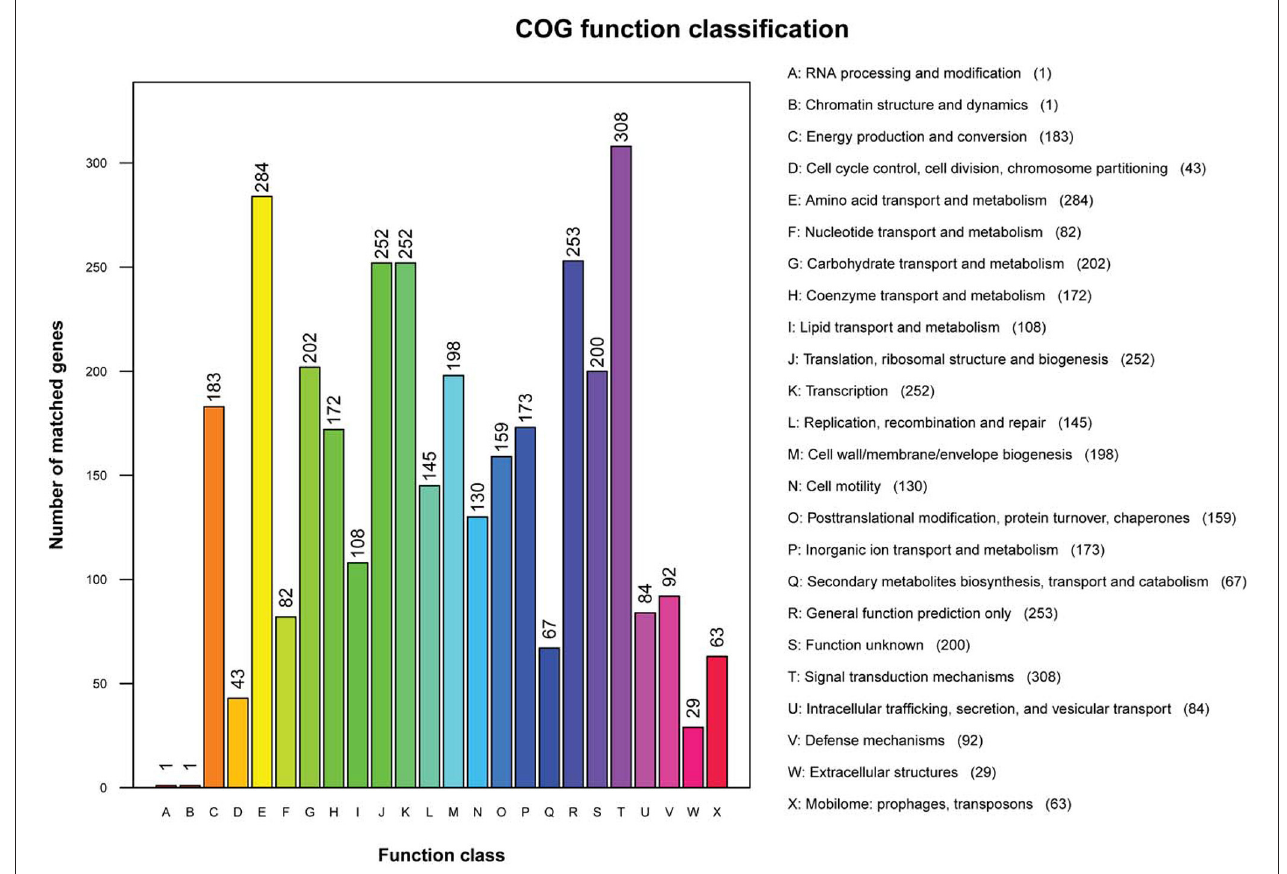
FIGURE 2 | The Clusters of Orthologous Genes (COG) functional annotation in the whole genome of non-O1/O139 V. cholerae strain GXFL1-4.